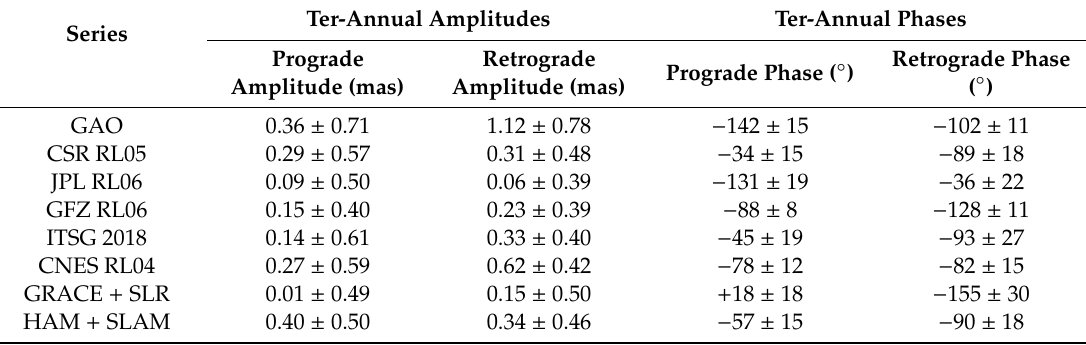
Table A4. Amplitudes and phases of prograde and retrograde ter-annual oscillations of GAO, GSM, and HAM + SLAM together with their errors. The phases refer to the reference epoch starting on 1 January